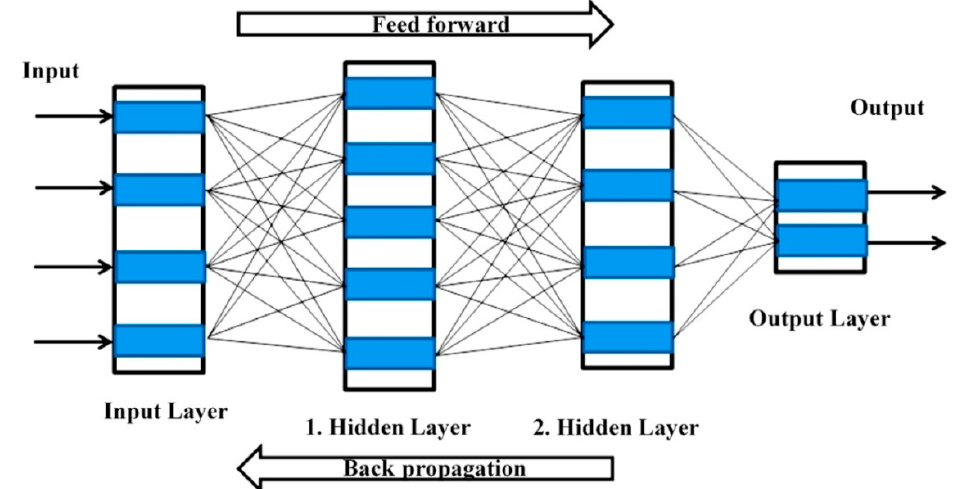
Figure 5. Scheme of the ANN.